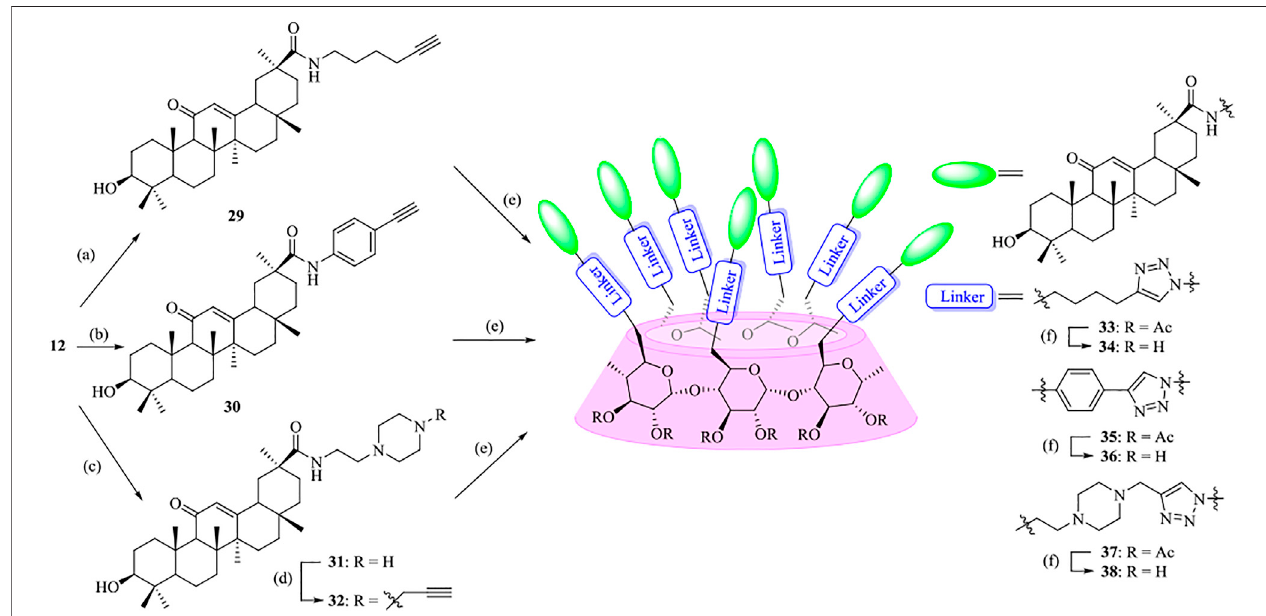
SCHEME2| Synthesisofheptavalent GA-functionalized β -CDconjugates ( 33 – 38 ).Reagents andconditions: (a)5-hexyn-1-amine, Na 2 CO 3 ,DMF,60 o C,90%;(b) 4-ethynylaniline, Na